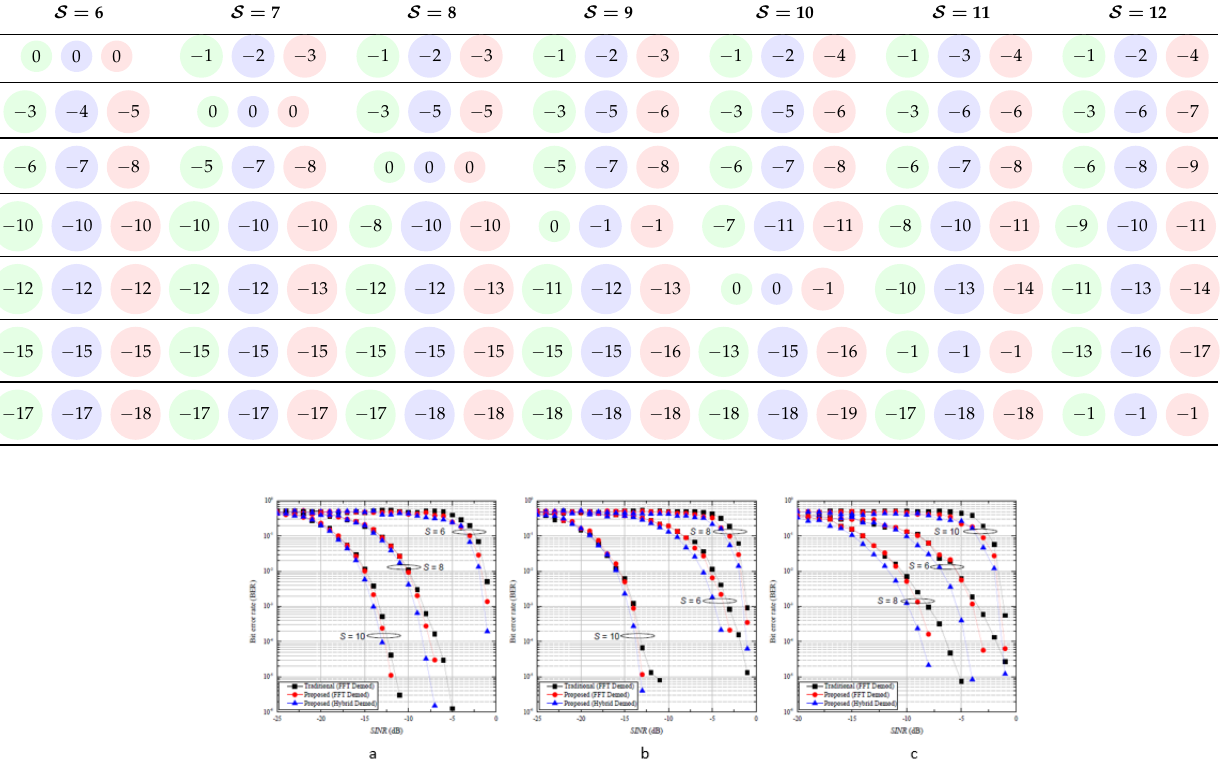
Figure 4. Performance comparison of different LoRa signals in the presence of interference. ( a ) Inter- = 6; ( b ) interference signal ference signal S